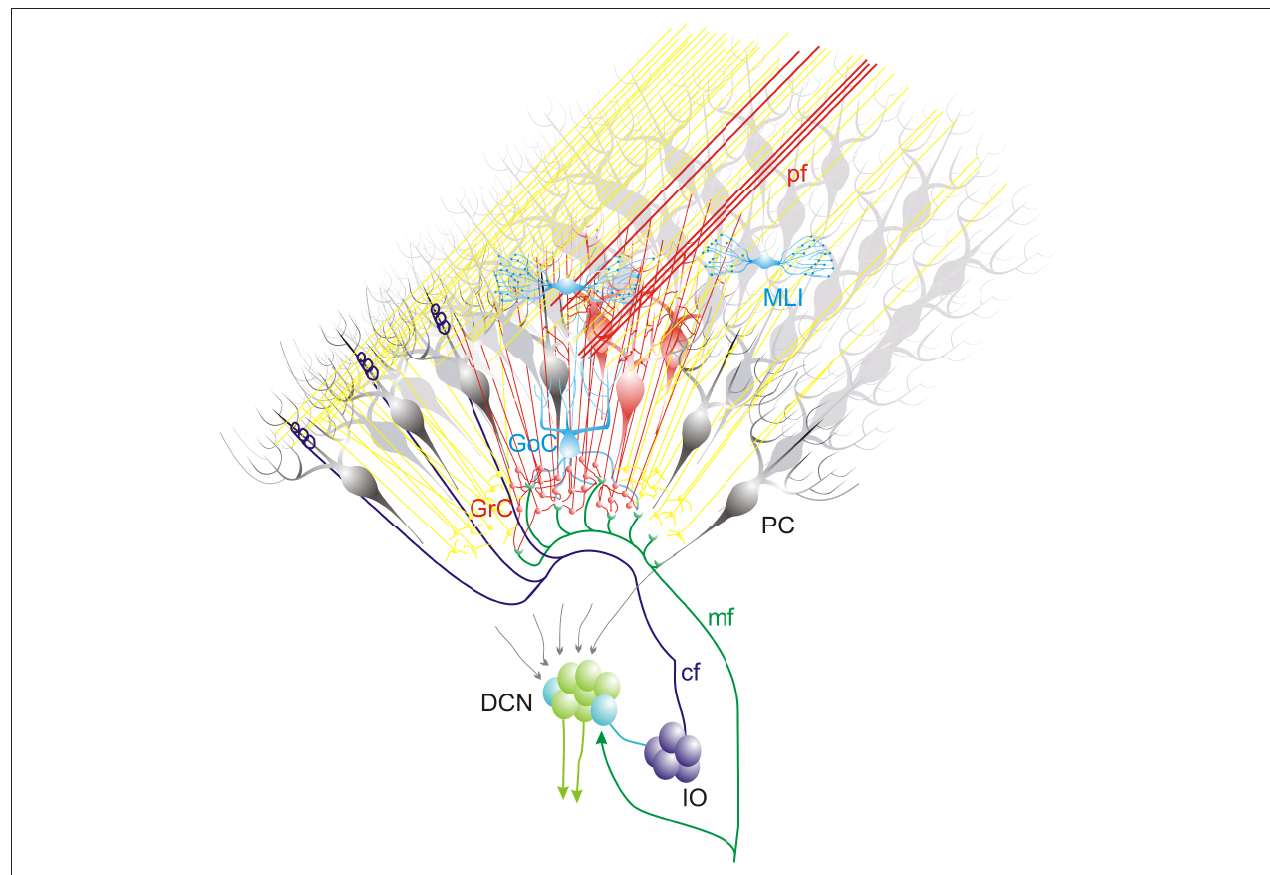
Figure 1 | Functional organization of the olivo-cerebellar system: a dynamic